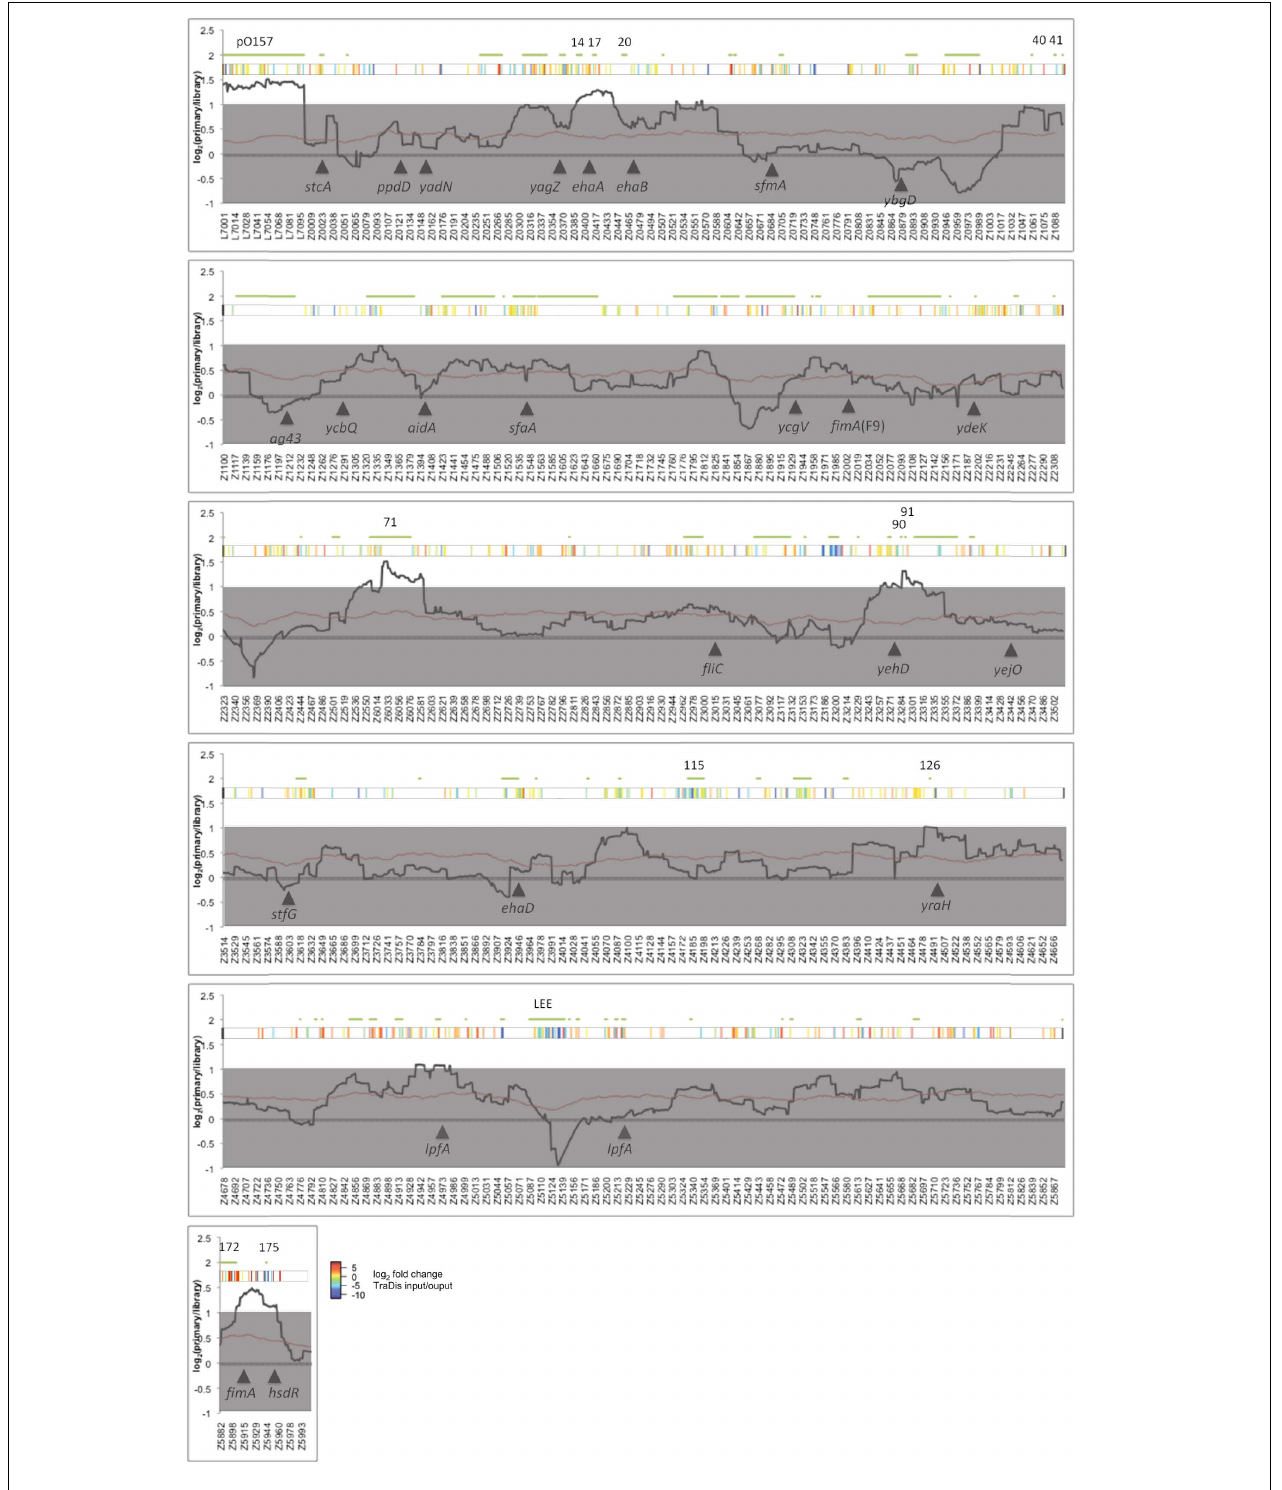
(window = 50 genes) applied.The black solid line indicates average ratio (output/input), the red line indicates the average p value and gray shading indicates an arbitrary two-fold cut-off for significance. Green lines and numbers above the plot indicate the location of O-islands. Solid arrowheads and designations indicate select genes implicated in adherence of E. coli